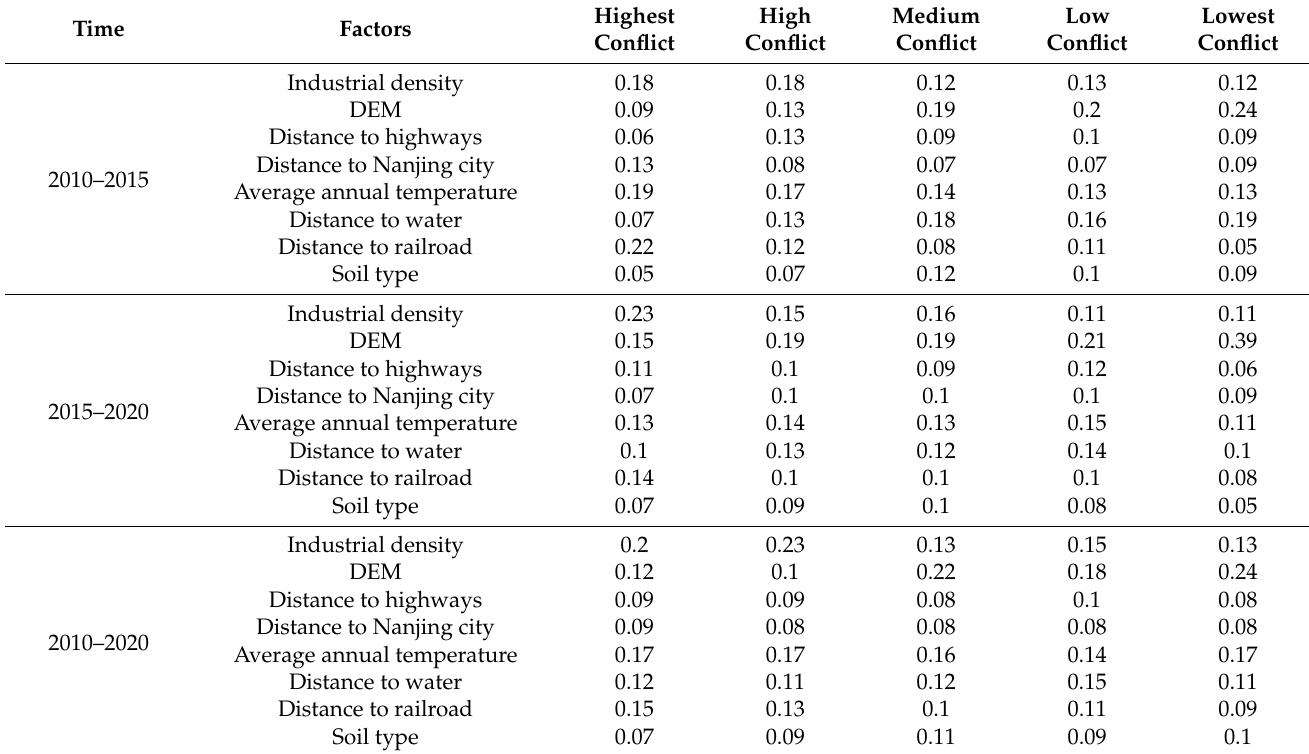
Table 6. Contribution weight values of related driving